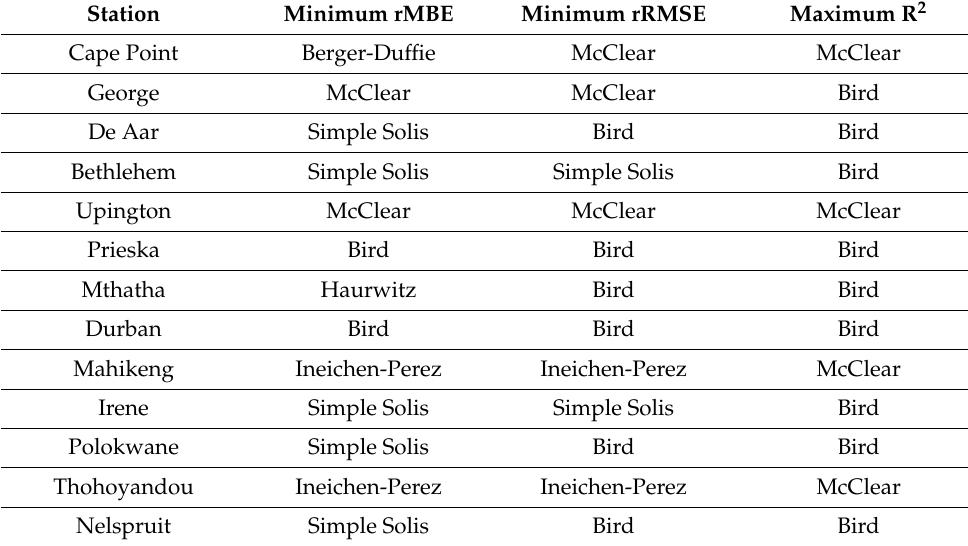
Figure 10. Stations grouped within climate zones with metrics normalised relative to the optimum value across all models and all stations, for each metric. Table 3. Optimum model w.r.t metrics for each